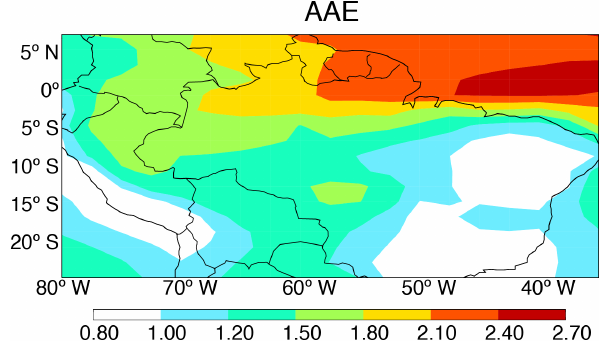
Figure 15. Model absorption Ångström exponent (AAE) based on AAOD at 400 and 550nm over the Amazon Basin averaged over January–April